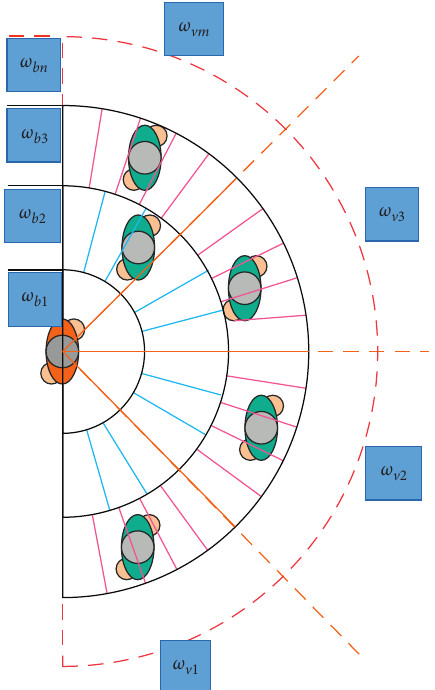
Figure 5: Schematic diagram of perception area division and weight